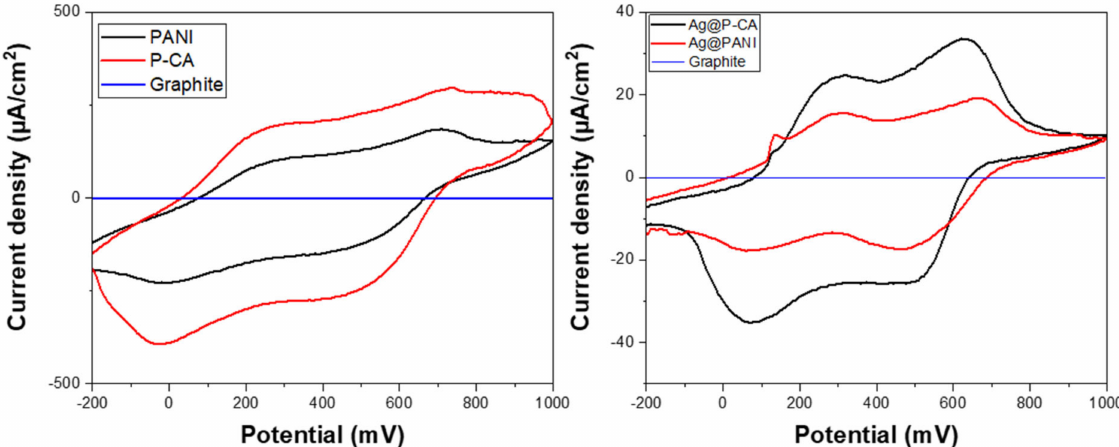
Figure 7. Cyclic voltammetry characterization of PANI-based composites in acidic solution (pH = 1). Left panel shows PANI materials without Ag NPs and the right panel shows PANI materials with Ag NPs. The CV analysis of synthesized ternary composites that contain Ag NPs was carried out at a scan rate of 20 mV · s − 1 and a potential range from − 200 to 1000 mV using the three-electrode system. The results in both panels are referenced to a pure graphite paste electrode material.